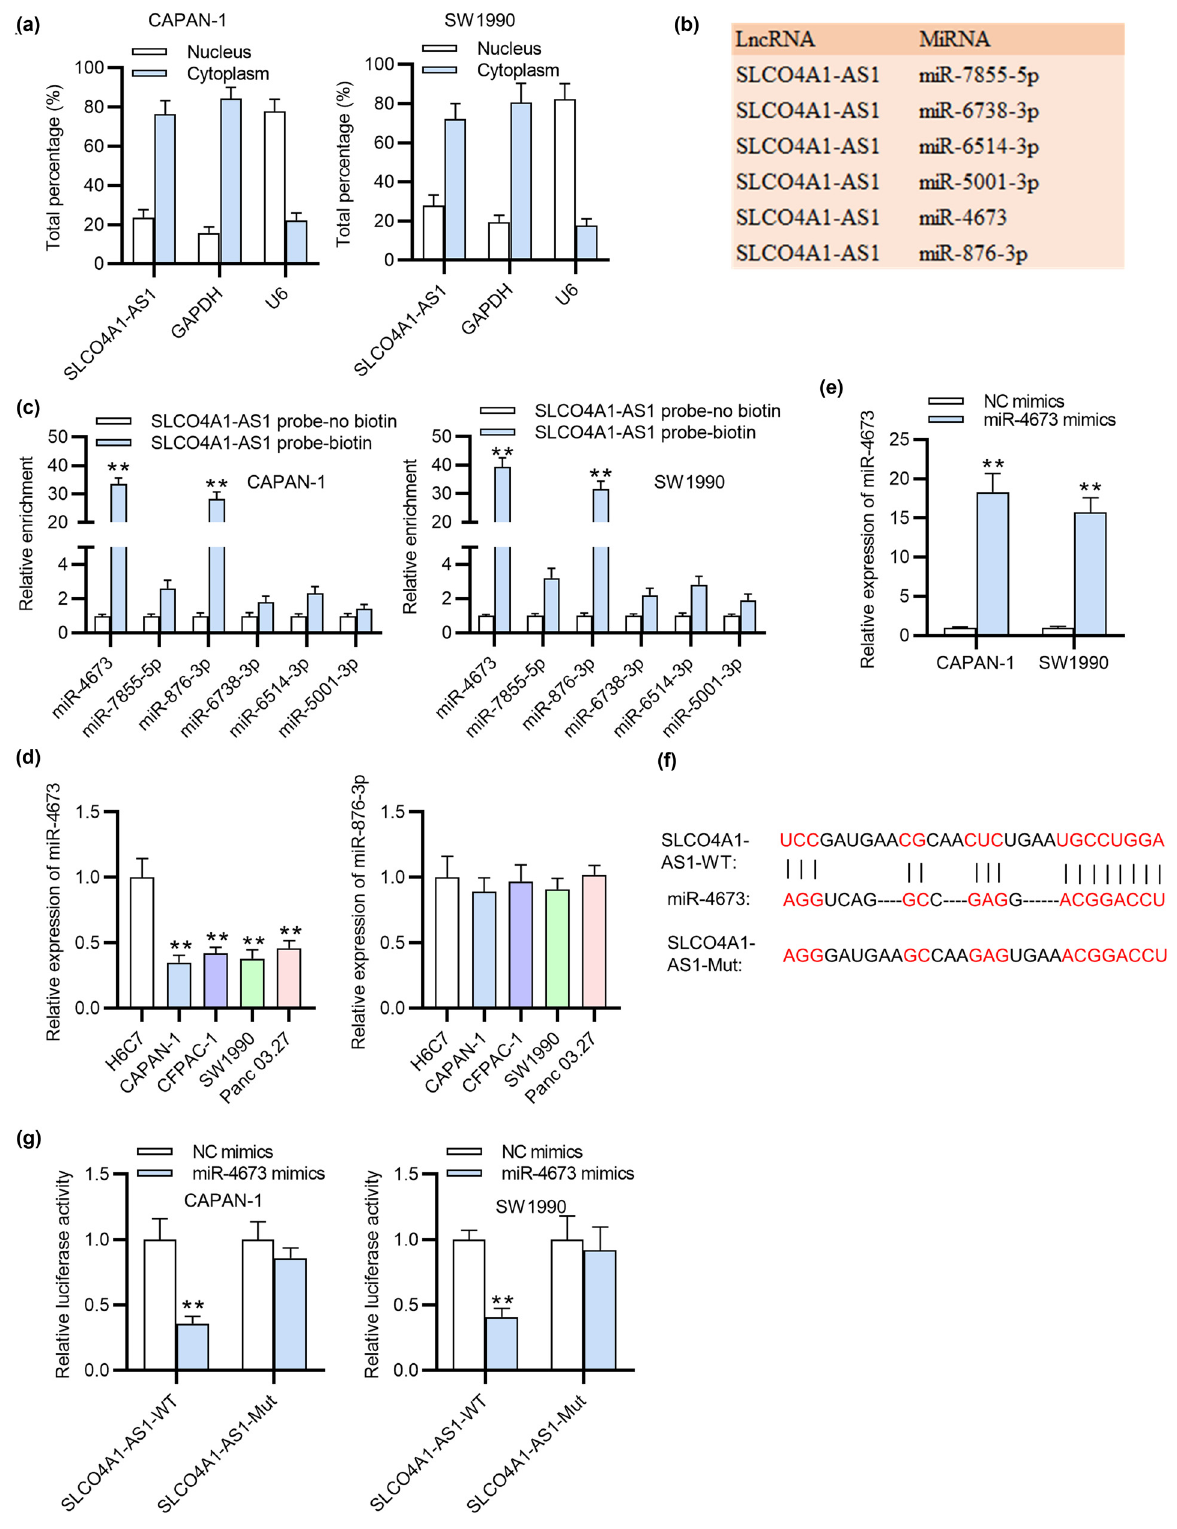
Figure 2: miR - 4673 is directly absorbed by SLCO4A1 - AS1. ( a ) Subcellular fractionation assay determined the localization of SLCO4A1 - AS1 in PC cells. ( b ) We searched the downstream miRNAs of SLCO4A1 - AS1 from the DIANA database. ( c ) RNA pull - down investigated the expression of candidate miRNAs pulled down by SLCO4A1 - AS1 probe - biotin in PC cells. ( d ) The levels of selected miRNAs in PC cells were measured through qRT - PCR. ( e ) The overexpression e ffi ciency of miR - 4673 was subjected to qRT - PCR. ( f ) The binding site of SLCO4A1 - AS1 on miR - 4673 is revealed from DIANA database. ( g ) Luciferase reporter assay was employed to examine the luciferase activity of SLCO4A1 - AS1 - WT and SLCO4A1 - AS1 - MUT in PC cells transfected with miR - 4673 mimics. All experiments were performed in triplicate. ** p <